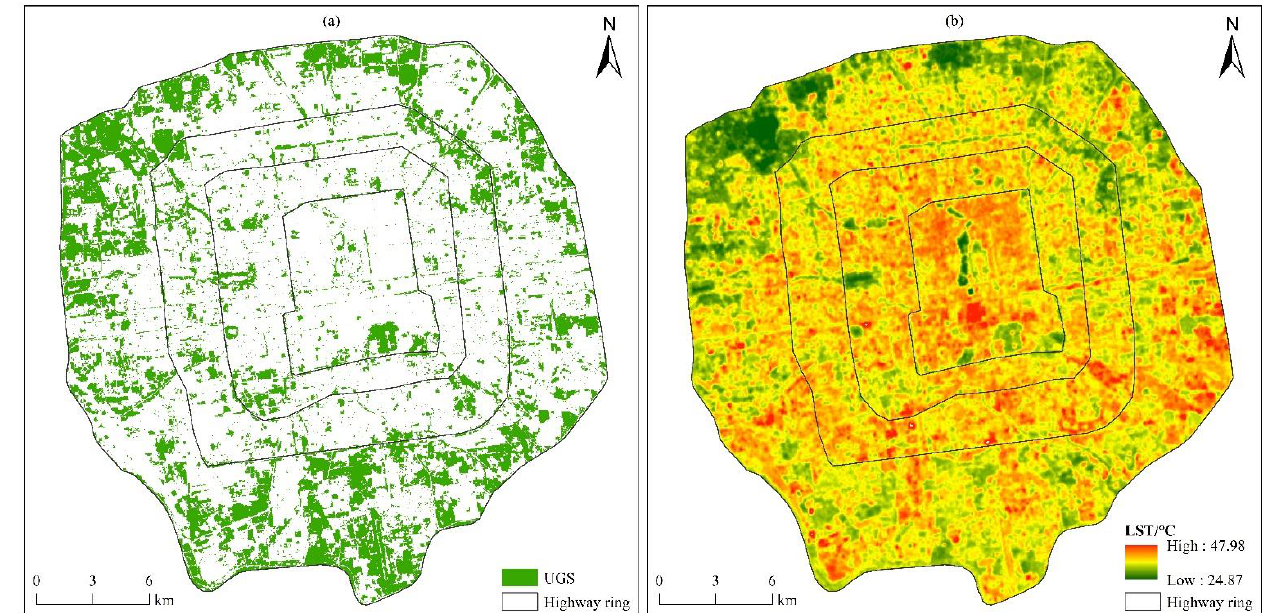
Figure 5. Spatial distribution of UGS and LST in the study area. ( a ) UGS; ( b ) LST.